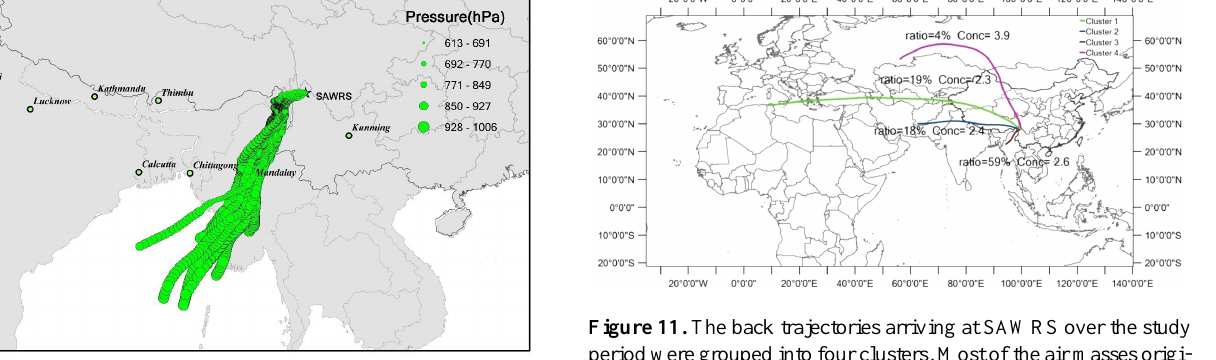
Figure 9. The back trajectories of air mass from 19 June to 2 July.